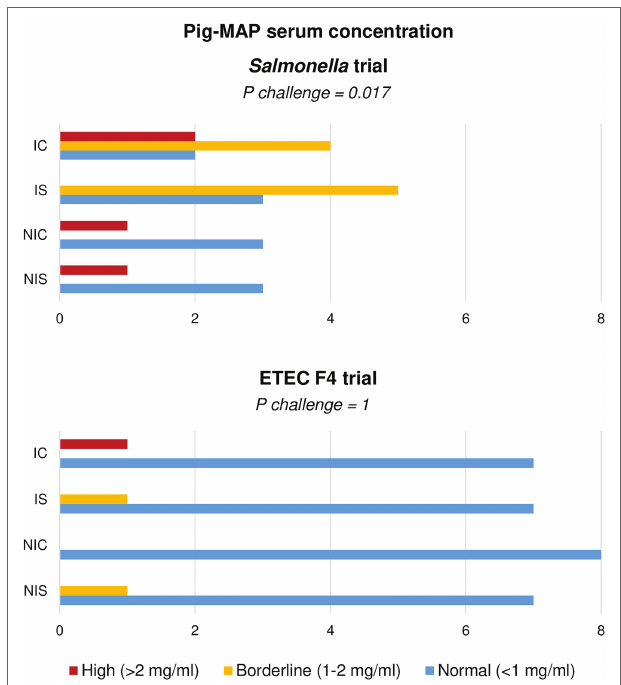
FIGURE 4 | Effect of experimental treatments in serum levels of acute-phase protein Pig-MAP in piglets on day 8 ( Salmonella trial) and 7 (ETEC F4 trial) following a pathogen oral challenge. Figure represents value frequencies between a normal (0.3–1 mg/ml) and abnormal (>2 mg/ml) range. IC, Inoculated animals receiving placebo; IS, Inoculated animals receiving the synbiotic; NIC, Non-inoculated animals receiving placebo; and NIS, Non- inoculated animals receiving the synbiotic. N = 8 for all experimental groups except for non-challenged animals in Salmonella trial, N = 4. Values of p were obtained using Fisher’s Exact Test on R